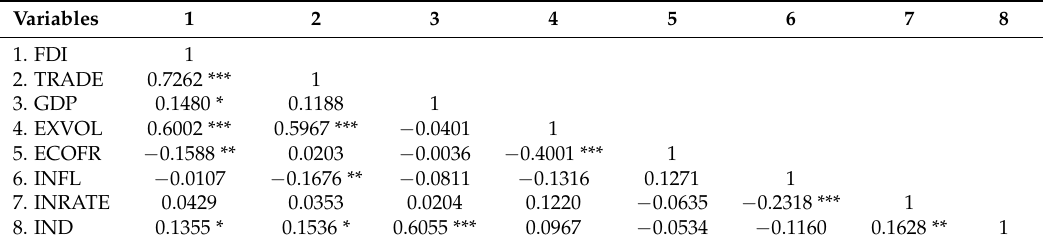
Table A1. Correlation Matrix with Exchange Rate Volatility (GARCH).